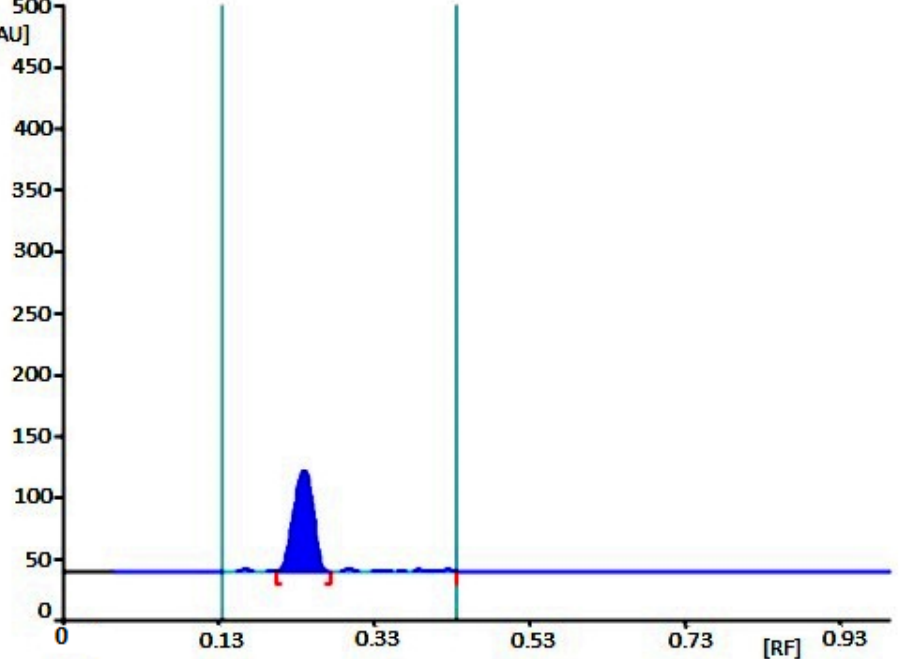
Figure 11. Chromatogram (densitogram) of fluoxetine (R F = 0.24), analyzed on silica gel 60 (1.05721) using the acetone + toluene + ammonia, 10:9:1 ( v/v/v ) mobile phase.